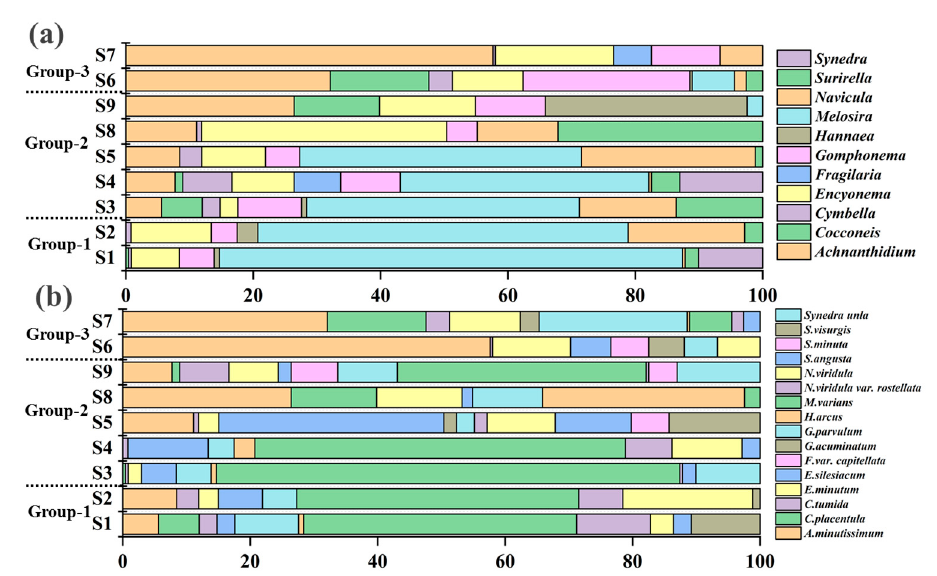
Figure 4. The composition of diatom in LLRB at genus-level ( a ) and species-level ( b ) during ice-covered period.